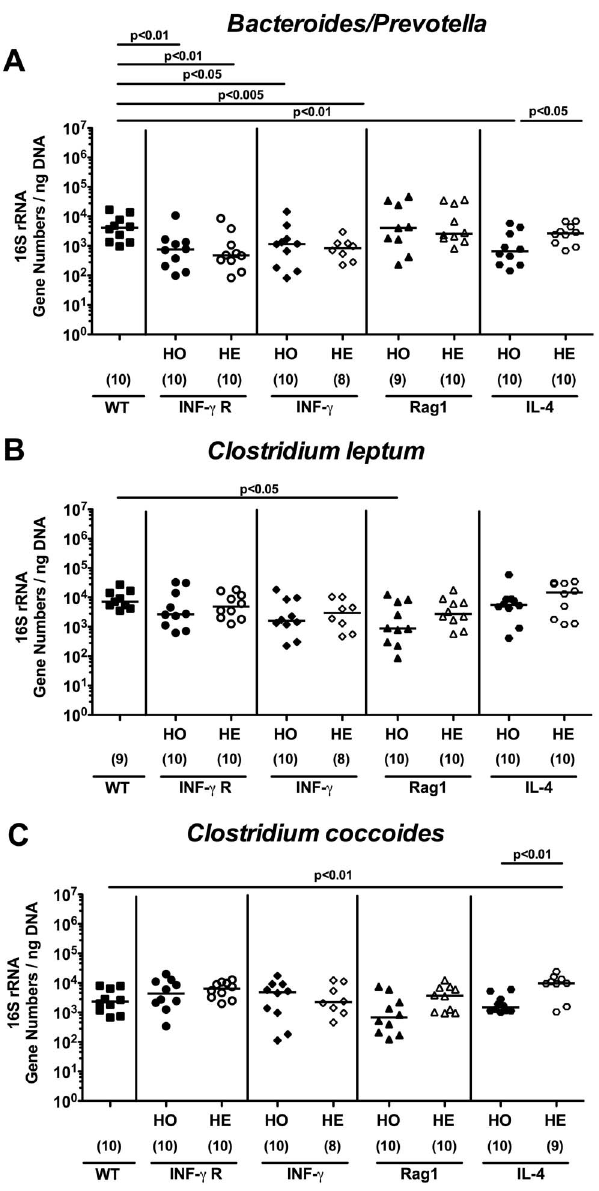
Figure 3. Commensal intestinal microbiota composition ( Bac- teroides/Prevotella spp., Clostridiumleptum and coccoides groups) of mice kept under SPF conditions. After twelve weeks of housing under SPF conditions, 16S rRNA of main intestinal bacterial groups was quantified by qRT-PCR in fecal samples derived from homozygous (HO; filled symbols) and heterozygous (HE; open symbols) mice deficient for IFN- c Receptor (IFN- c R; circles), IFN- c (diamonds), Rag1 (triangle), or IL- 4 (hexagons). Wildtype C57BL/6 (WT, black squares) served as controls. Quantitative abundance of ( A ) Bacteroides/Prevotella spp., ( B ) Clostrid- ium leptum group and ( C ) Clostridium coccoides group are expressed in gene numbers per ng DNA. Medians (black bars), levels of significance ( P -values) determined by the Mann-Whitney-U test and numbers of analyzed animals (in parentheses) are indicated. doi:10.1371/journal.pone.0113406.g003 Rag1-deficient mice of either genotype irrespective of the housing condition.